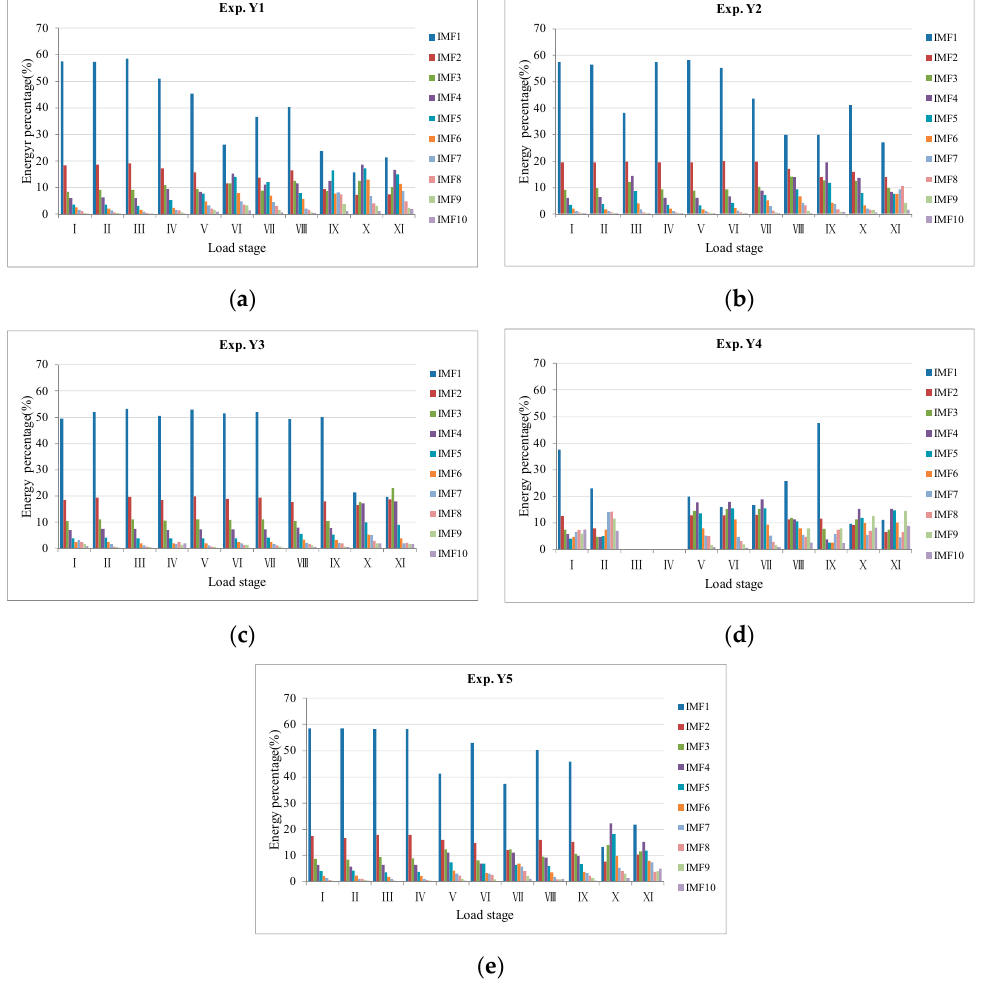
Figure 8. Intrinsic mode function (IMF) energy distribution graph of each load stage in Exp.Y1–Y5. ( a ) Exp.Y1; ( b ) Exp.Y2; ( c ) Exp.Y3; ( d ) Exp.Y4 and ( e ) Exp.Y5.